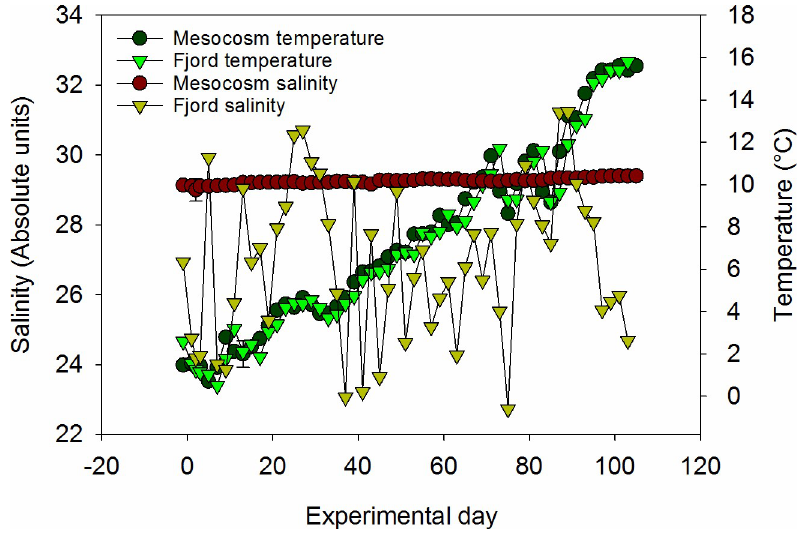
Fig 1. Salinity and temperature profiles in the mesocosms and fjord throughout the